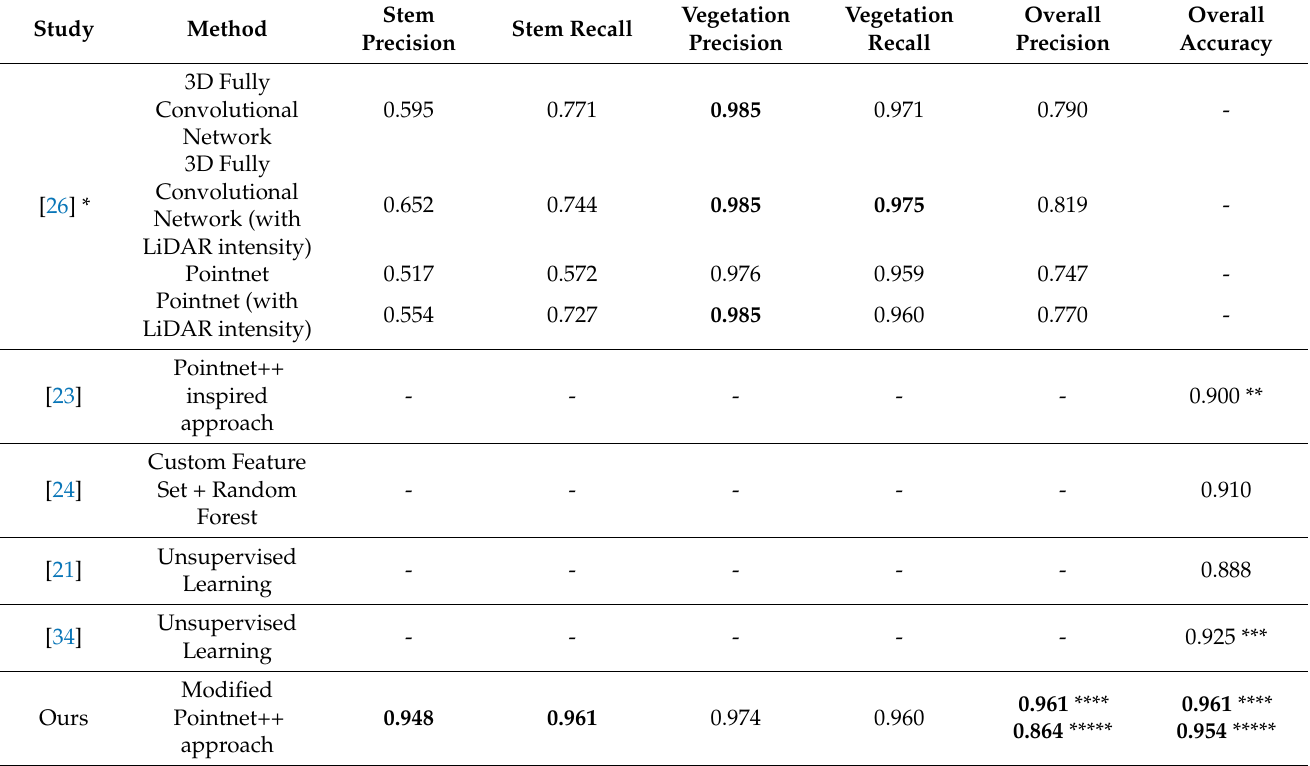
Table 4. Comparison of segmentation results against similar studies. Bold numbers denote the top score in each metric.